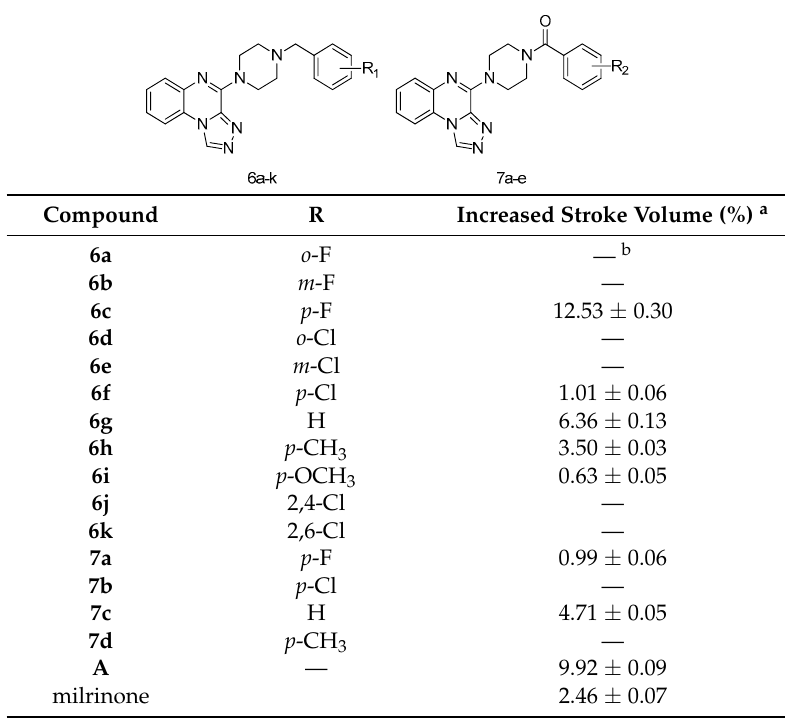
Table 1. Positive inotropic activity of the test compounds.